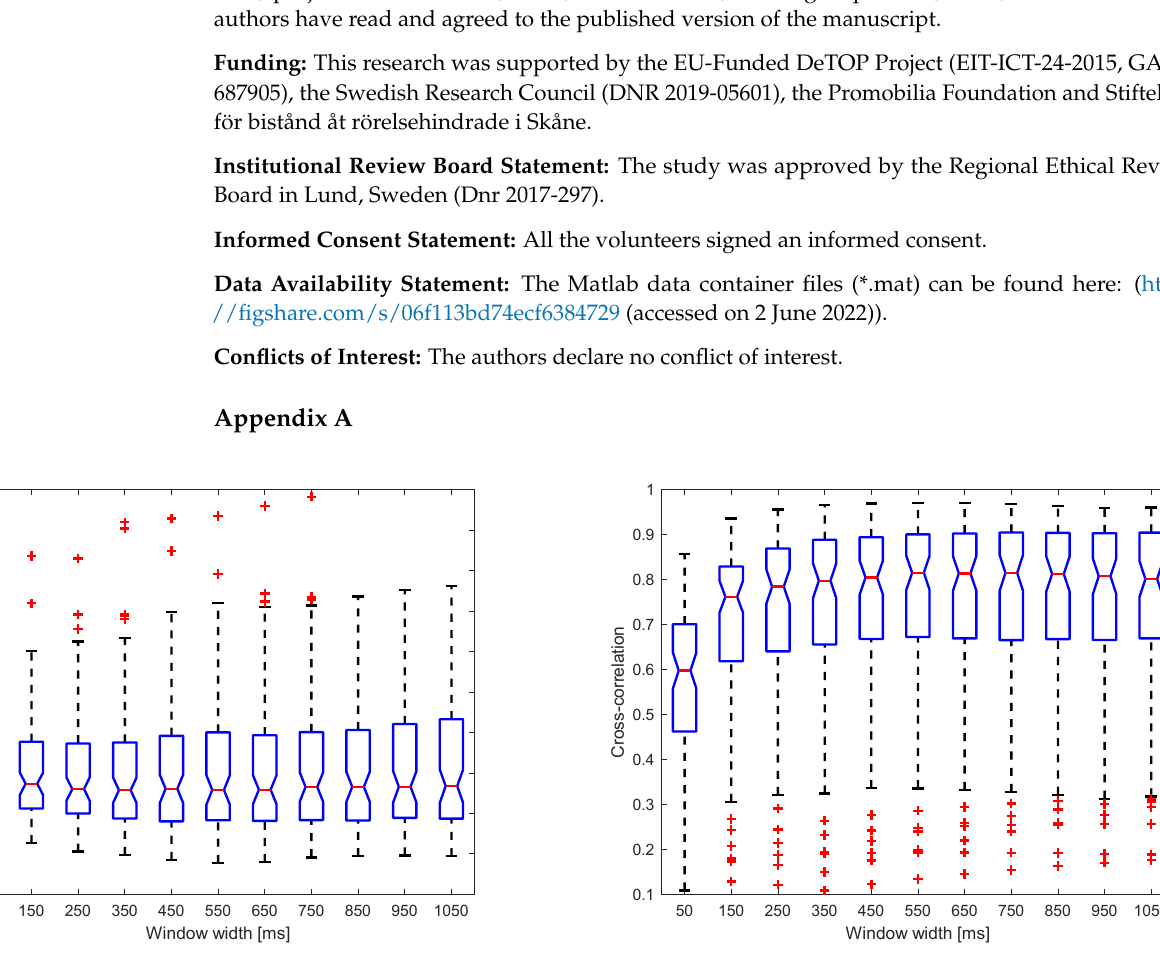
Figure A1. RMSE ( left ) and cross-correlation ( right ) of var algorithm for different window sizes. Table A1. Statistical significance between window sizes for var algorithm. Green indicates statisti- cally significant difference ( p < 0.05; Bonferroni-corrected) for the RMSE metric, and orange indicates significant difference ( p < 0.05; Bonferroni-corrected) for the cross-correlation metric. Grey indicates diagonal fields.